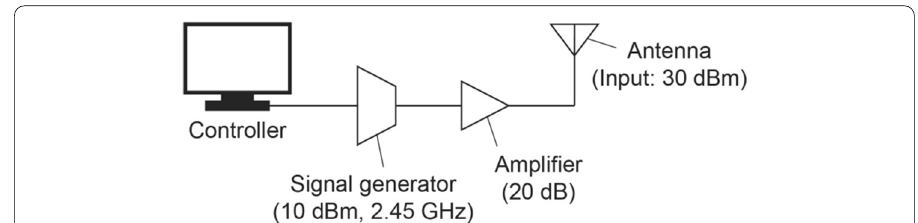
Fig. 7 Antenna powering setup for temperature measurement